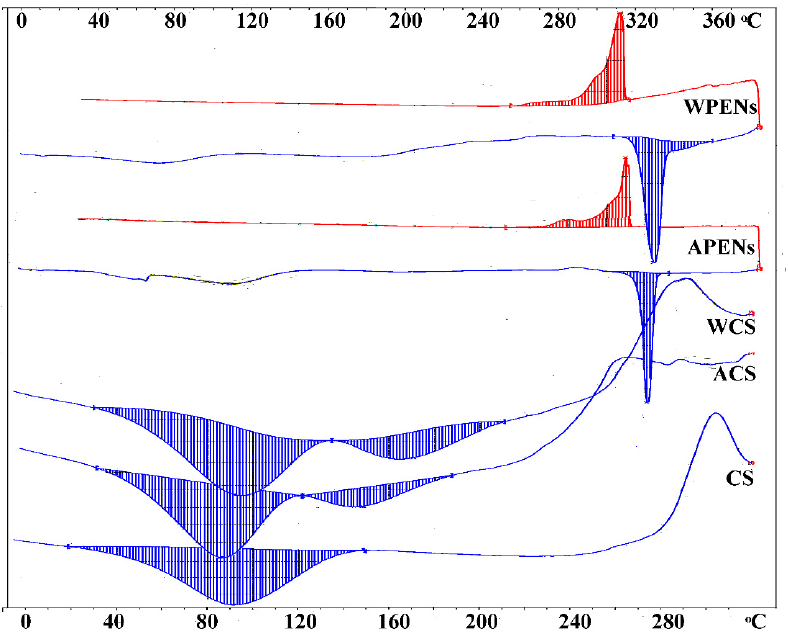
Figure 6. DSC curves of CS, CS derivatives (i.e., ACS, WCS), and PENs (i.e., APENs and WPENs).